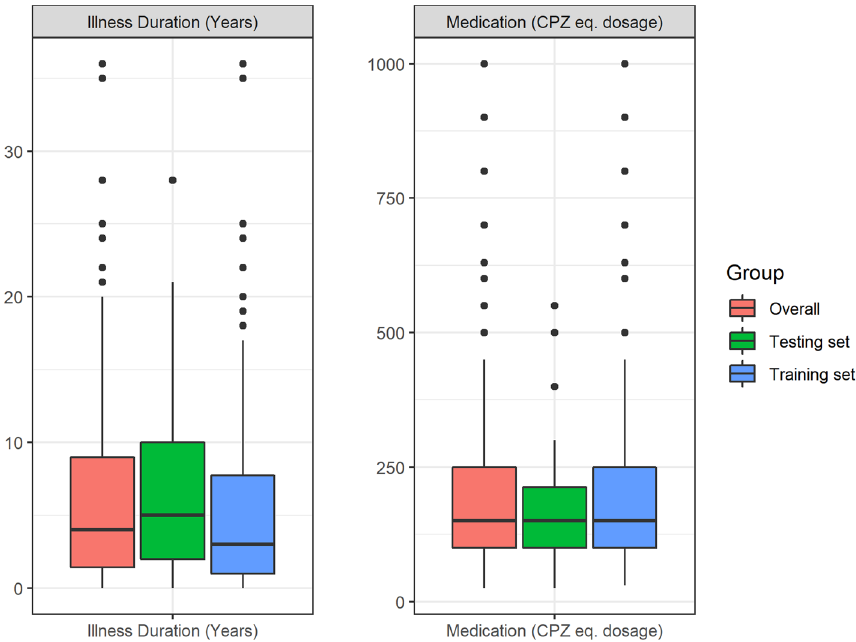
Figure 7. Illness duration (in years) and medication status (chlorpromazine equivalent dosage) distribution in patient